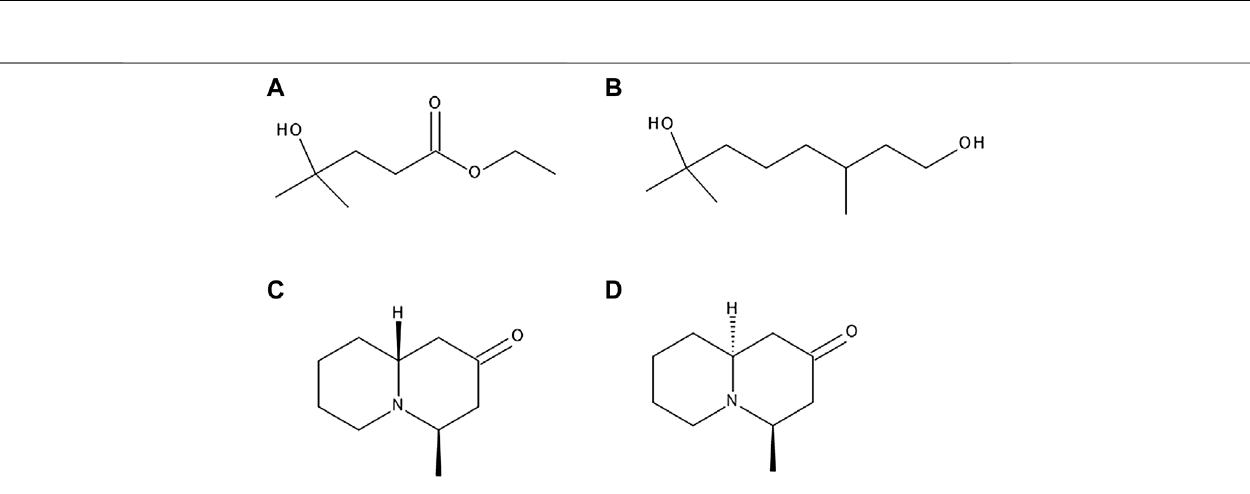
Frontiers in Pharmacology |